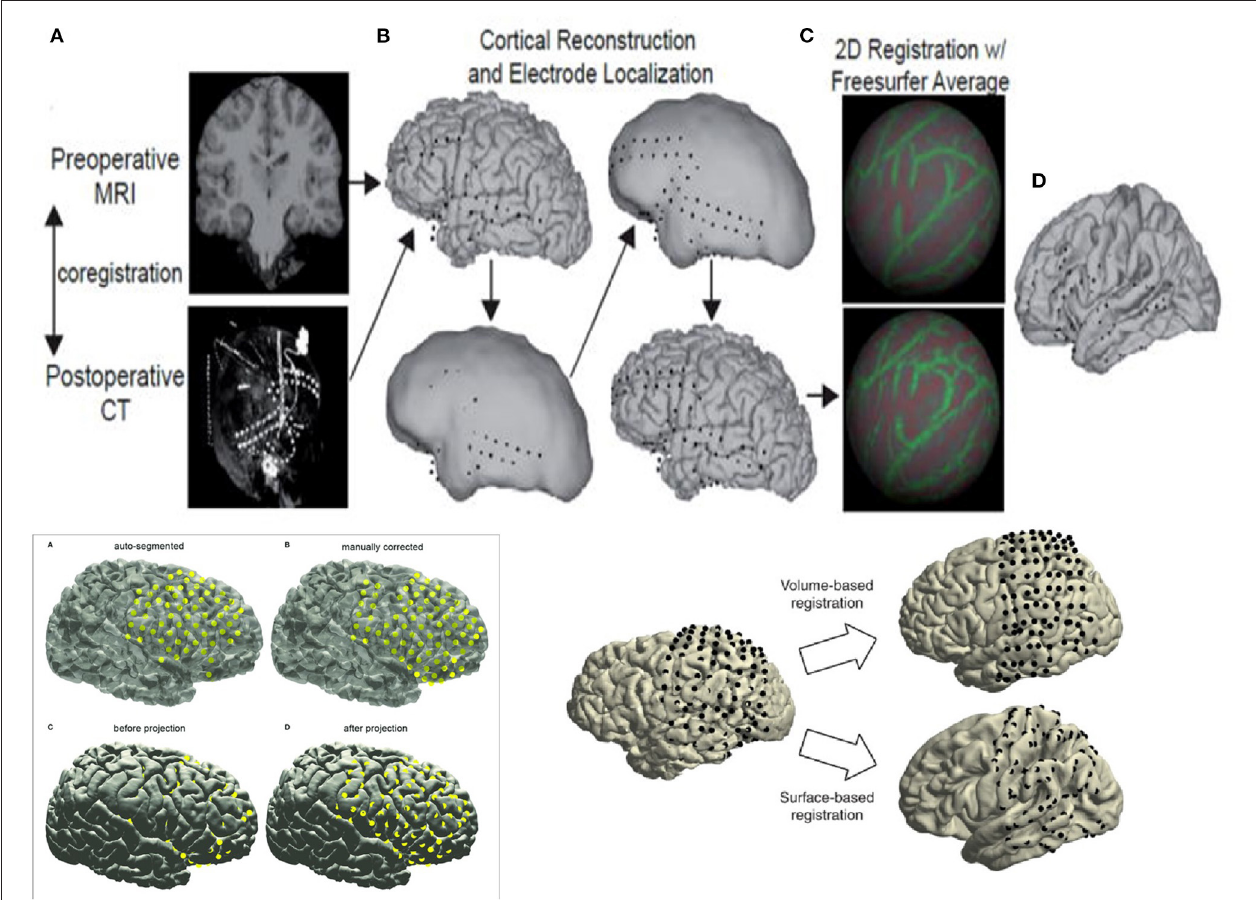
FIGURE 1 | Basic principles of reconstruction. (A) Left hand Top corner - Preoperative MRI and postoperative CT scan are superimposed to produce the reconstructions. (B) Top Center - Electrode contacts and Brain Cortex are recreated to design the reconstruction accurately. (C) Right hand Top corner - Reconstruction is begun using software like Freesurfer to reconstruct brain in 2 dimensions before collation into 3 dimensions. (D) Right extreme Top corner - Reconstructed images with superimposed electrode contacts are seen at the end. Left hand Bottom corner - Images (A–D) show the principles of reconstruction using software and manual corrections - automatic segmentation of imaging followed by manual correction proceeding to preliminary reconstructions followed by final reconstruction with smoothing out of images and confirmation of cortical anatomy. Right hand Bottom corner - Images showing the use of the 2 main techniques in reconstruction - volume based recon vs cortical surface anatomy based